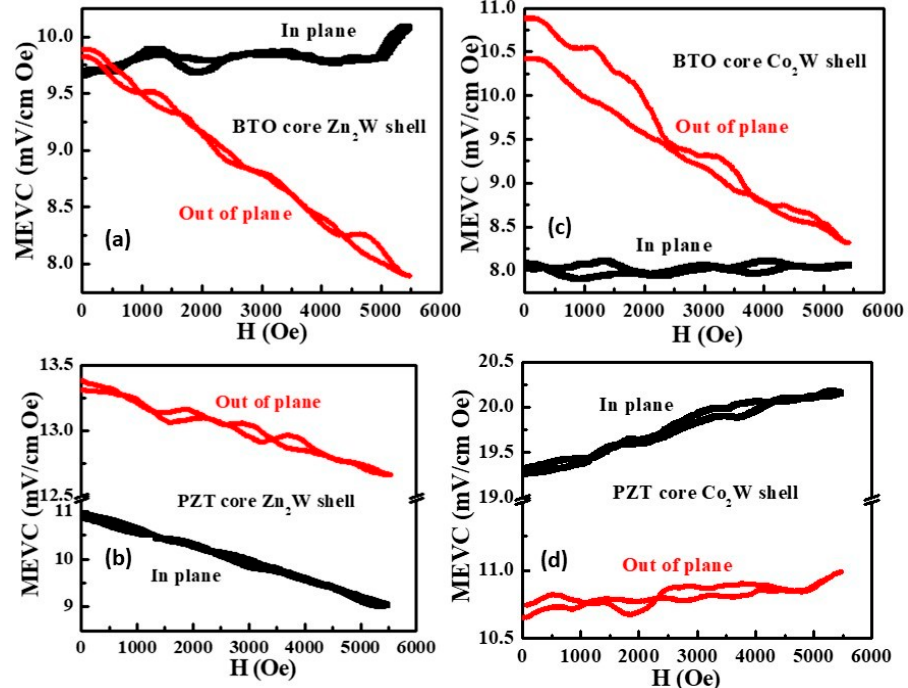
Figure 14. Data as shown in Figure 13 for films of fibers with ferroelectric core and W-type ferrite shells. ( a ) BTO and Zn 2 W, ( b ) PZT and Zn 2 W, ( c ) BTO and Co 2 W, and ( d ) PZT and Co 2 W.